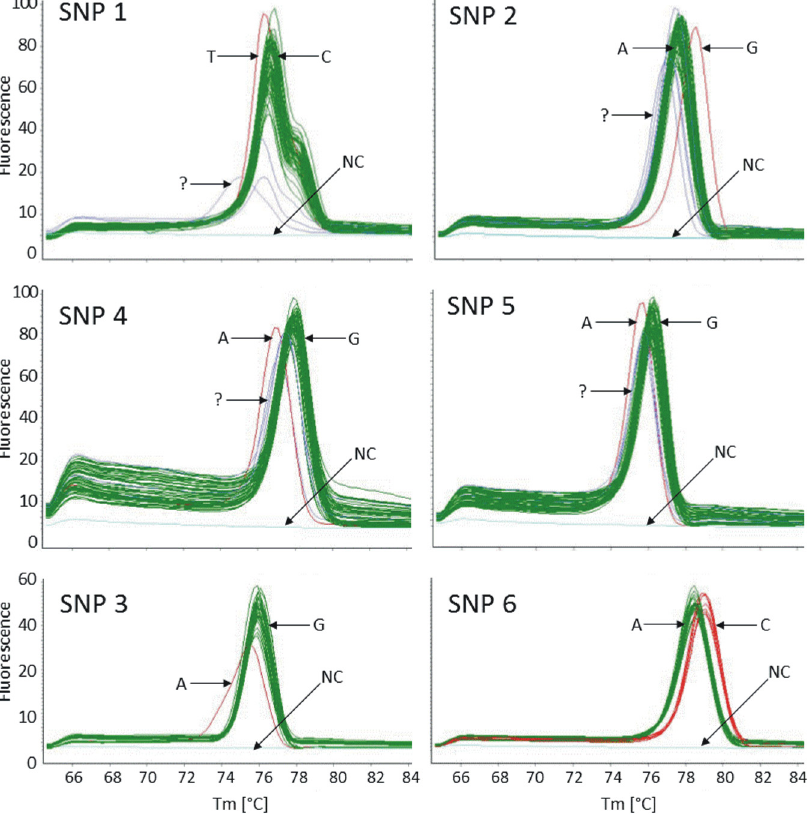
Fig 3. Temperature-dissociation (melt) curve derivatives of HRM-SNP. The relative fluorescence signal is plotted against the melting temperature (°C) for each SNP. Curves showing ancestral alleles (same base as predominant Pollino allele) are displayed in green. Curves indicating derived alleles (variant allele at the SNP-position) are displayed in red. The respective bases at the SNP position ( “ G ” or “ A ” ) are indicated for each allele group. Inconsistent curves ( “ ? ” ) are displayed in blue. Negative controls ( “ NC ” ) are displayed in